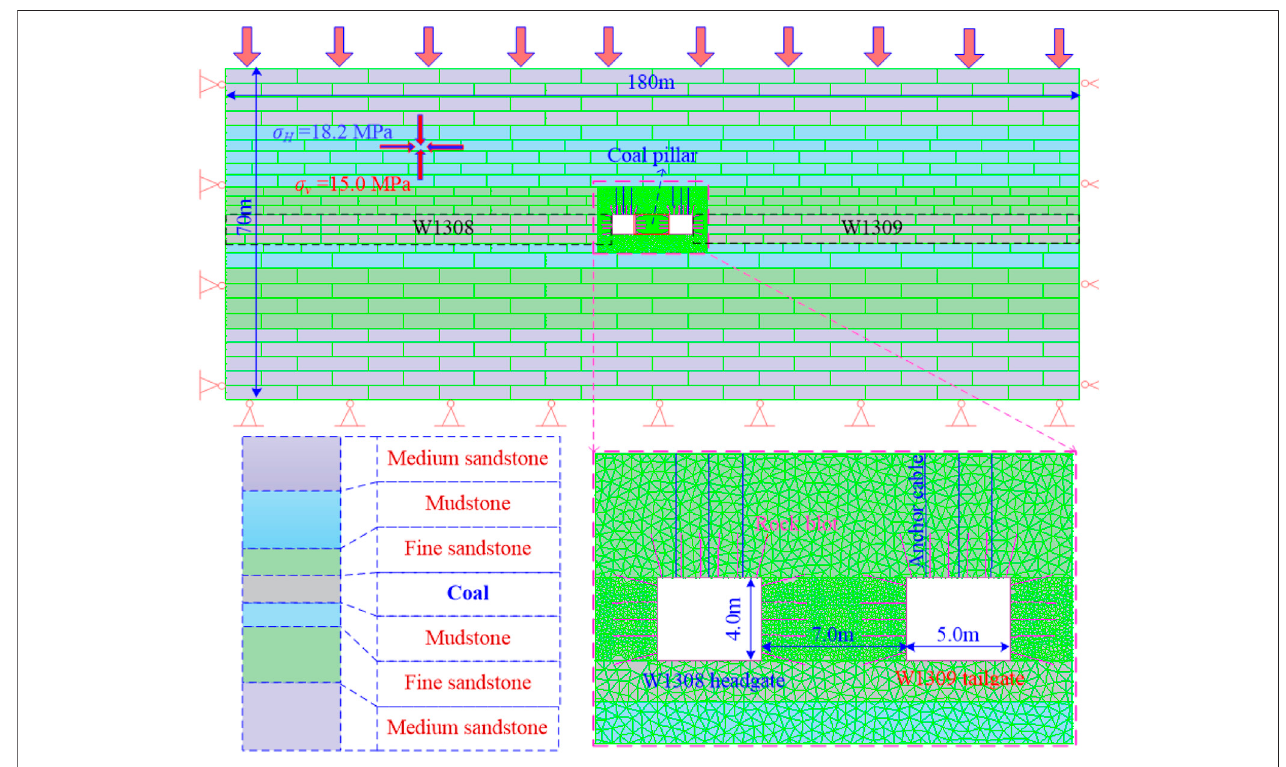
FIGURE 4 | Numerical calculation model for stability analysis of coal pillar and its supporting structure under repeated mining disturbances.